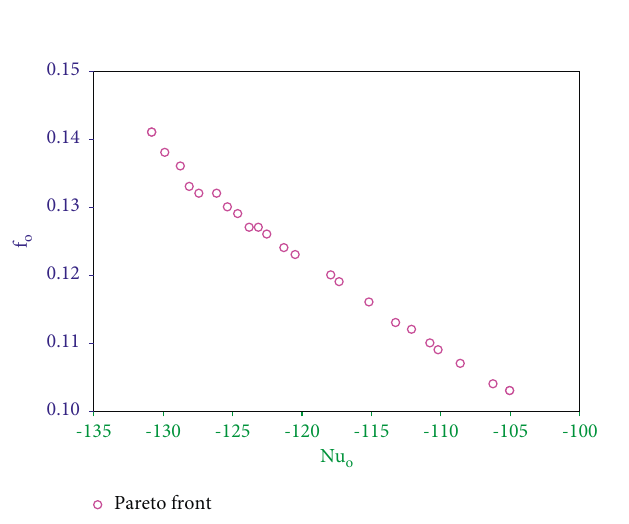
Figure 13: Optimal Pareto front